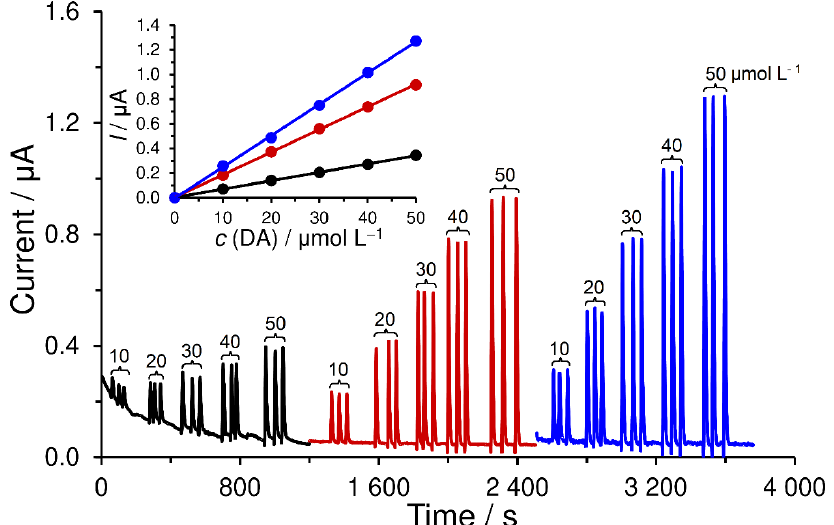
Figure 7. Typical amperogram of calibration measurements of dopamine (DA) obtained at bare SPCE (black), SPCE/PC (red), and SPCE/PV (blue curve) in FIA arrangement. Supporting electrolyte; 0.1 mol L −1 AcB (pH 4.5, not de-aerated), detection potential, +0.4 V; injection volume; 100 μL, flow rate; 1.0 mL min −1 , and laboratory temperature; 25 °C.